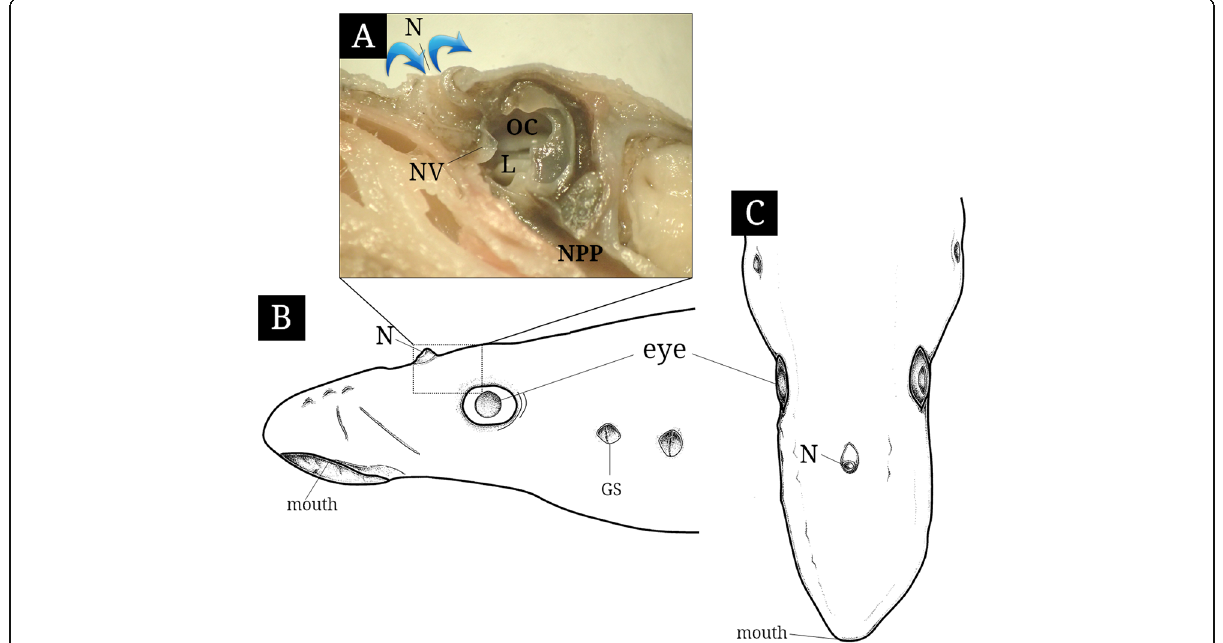
Fig. 2 The photograph ( a ) of inner structure and schematic diagrams of lateral ( b ) and upper views of the olfactory organ in Lethenteron reissneri . The blue arrows indicate water flowing. GS, external gill slit; L, lamellae; N, nostril; NPP, nasopharyngeal pouch; NV, nasal valve; OC, olfactory